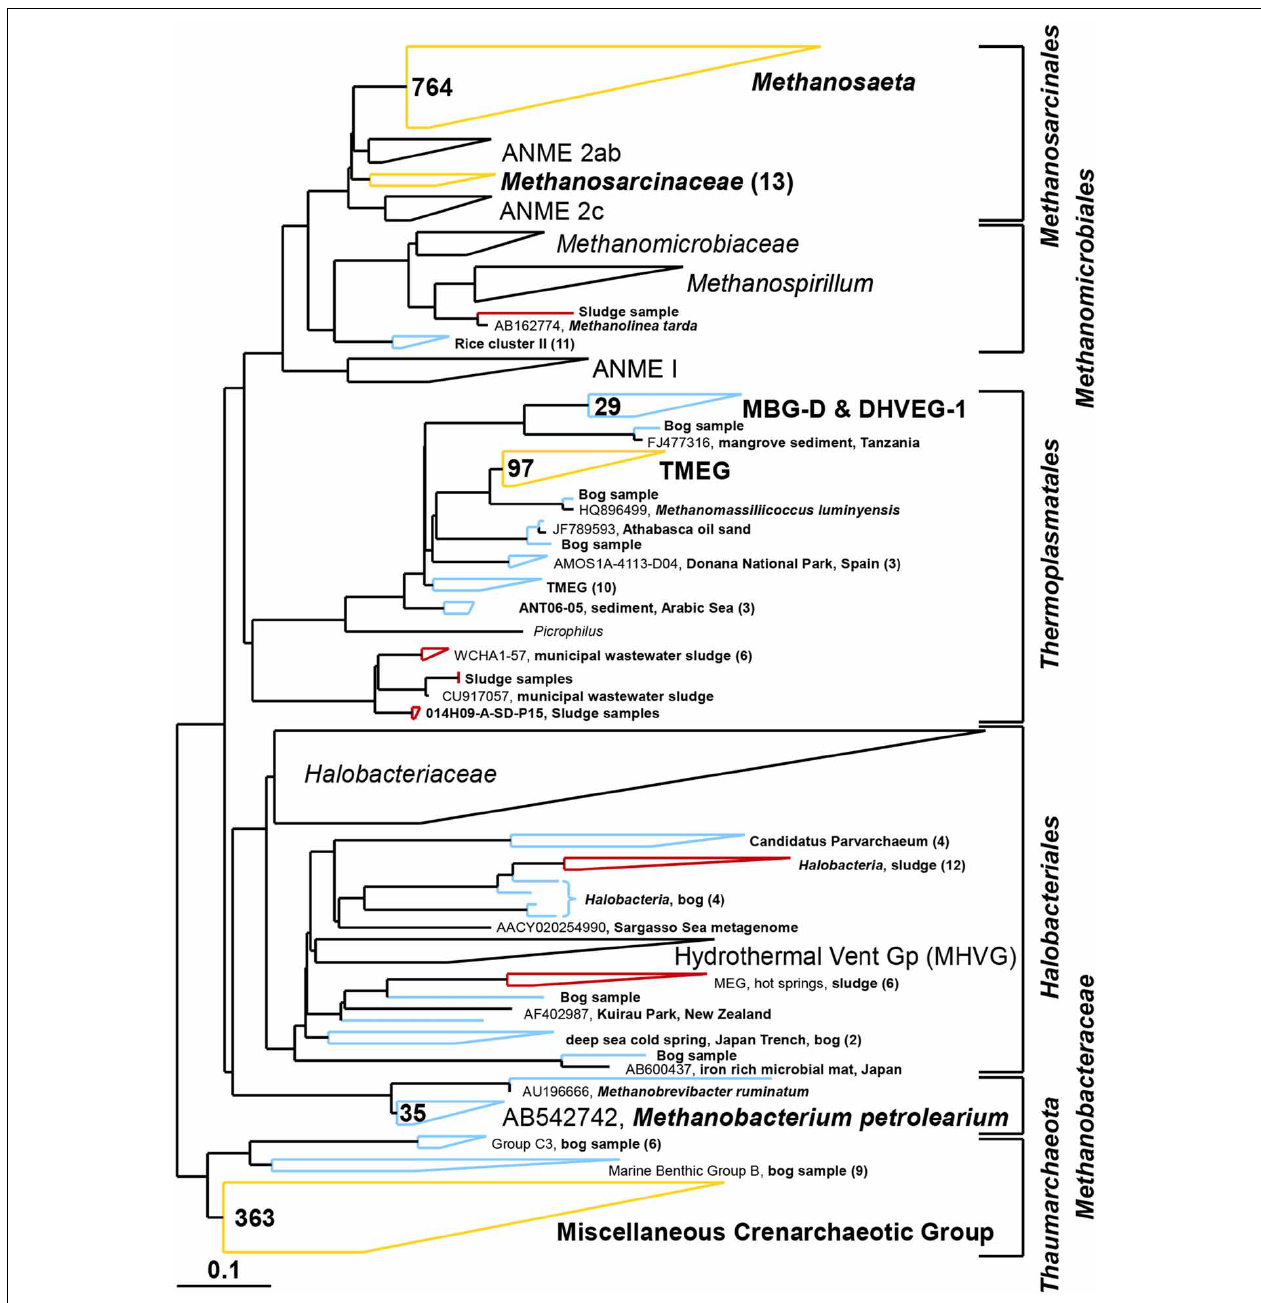
FIGURE 8 | Composite maximum parsimony phylogenetic tree constructed by incorporating archaeal sequences of the bog sediment (blue) and the AD sludge (red) into an existing SILVA 115 NR99 tree.